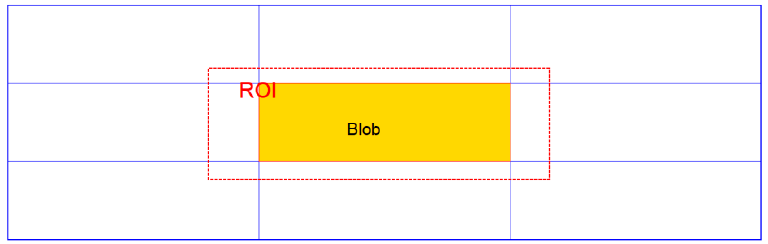
Figure 15. A sketch of the region of interest (ROI) based on the blob and restrained by constraints.